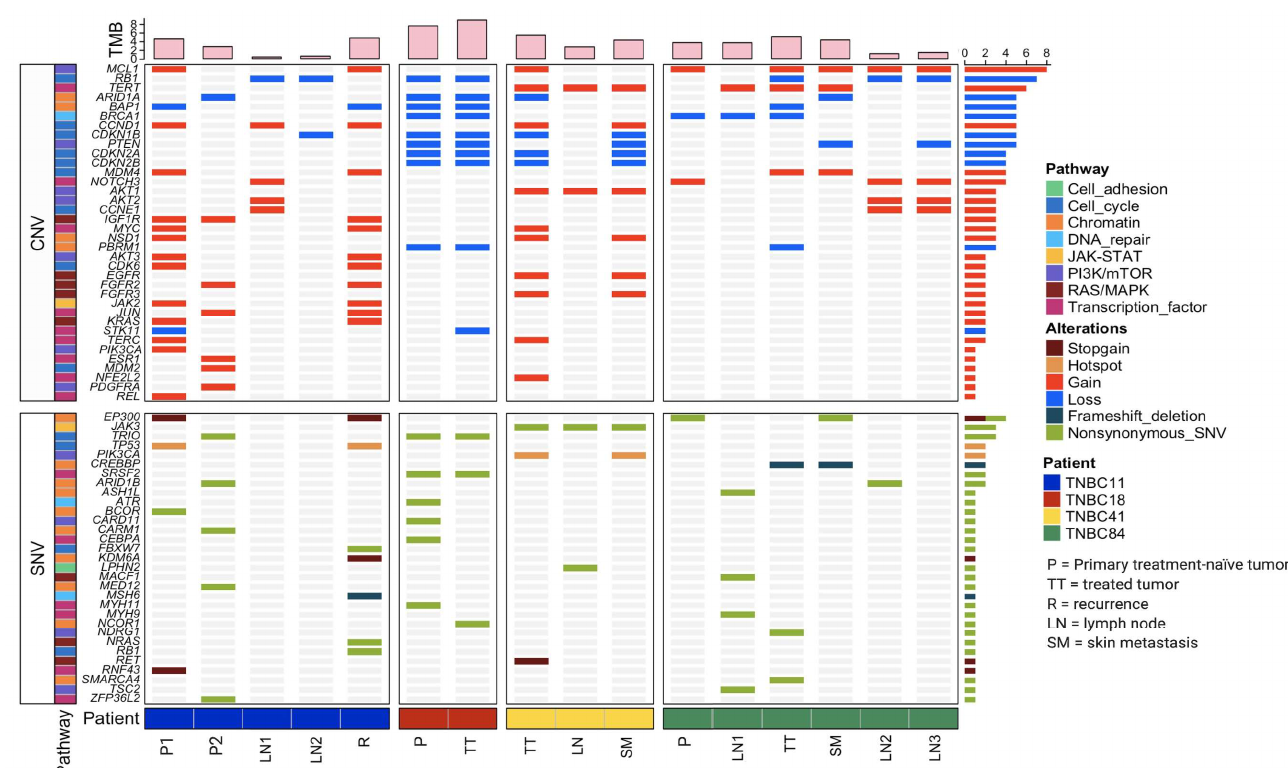
Figure 2. Allelic composition and CNV alterations in driver genes. The samples were segmented and color-coded by patient and sorted chronologically. TMB is indicated on the top panel with pink bars. Driver genes are classified into two categories: SNV (lower panel) and CNV (upper panel). Mutation signaling pathways in which driver genes are involved, as well as mutation types, are denoted by distinct